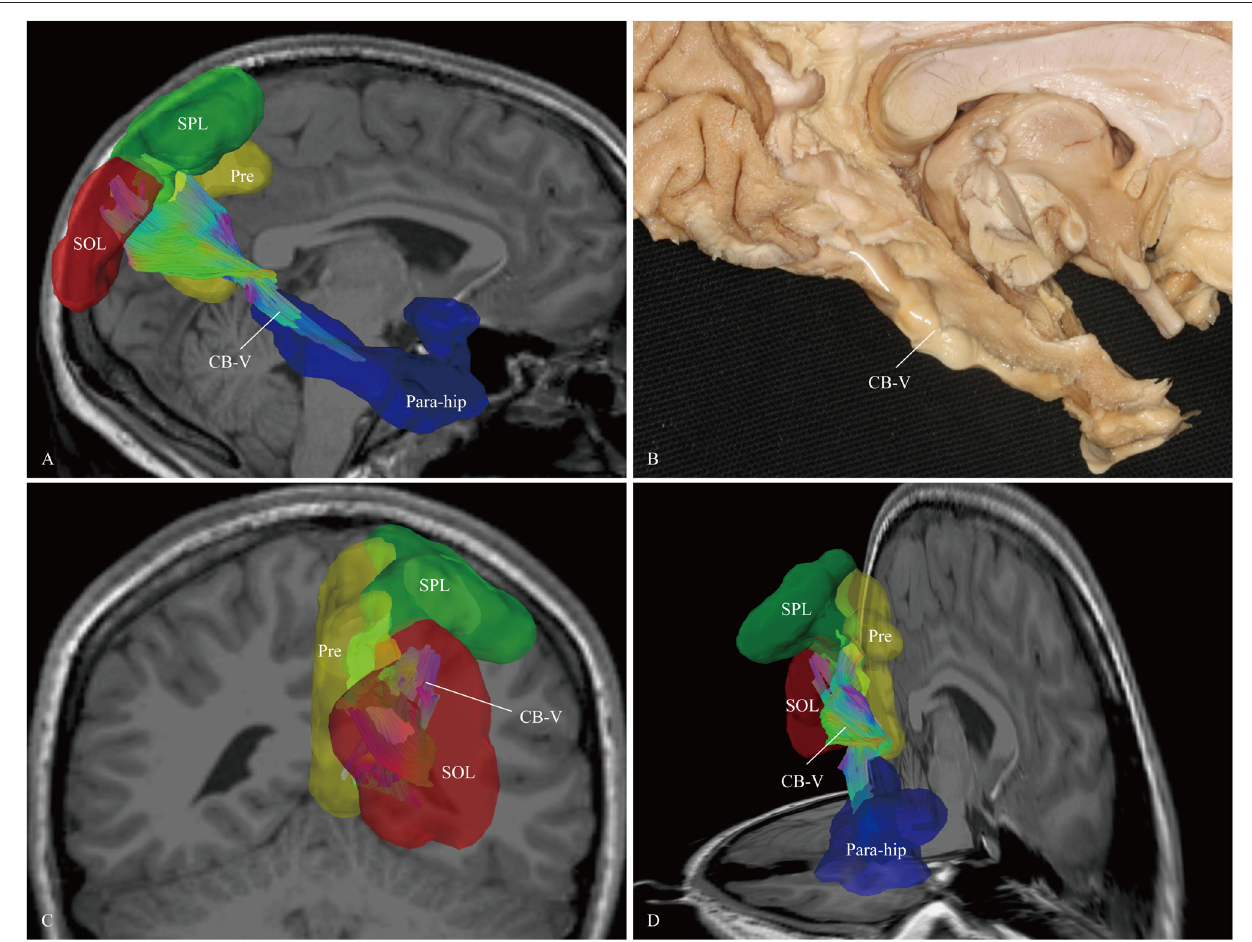
FIGURE 7 | In vivo fiber tractography and fiber microdissection of the CB-V. (A,B) The CB-V extends along the para-hippocampal gyrus, (C,D) then fans out to the parietal and occipital lobes. The scattered fibers in the parietal and occipital lobes are failed to be identified in fiber dissection. Para-hip, para-hippocampal gyrus; SPL, superior parietal lobule; Pre, precuneus; SOL, superior occipital